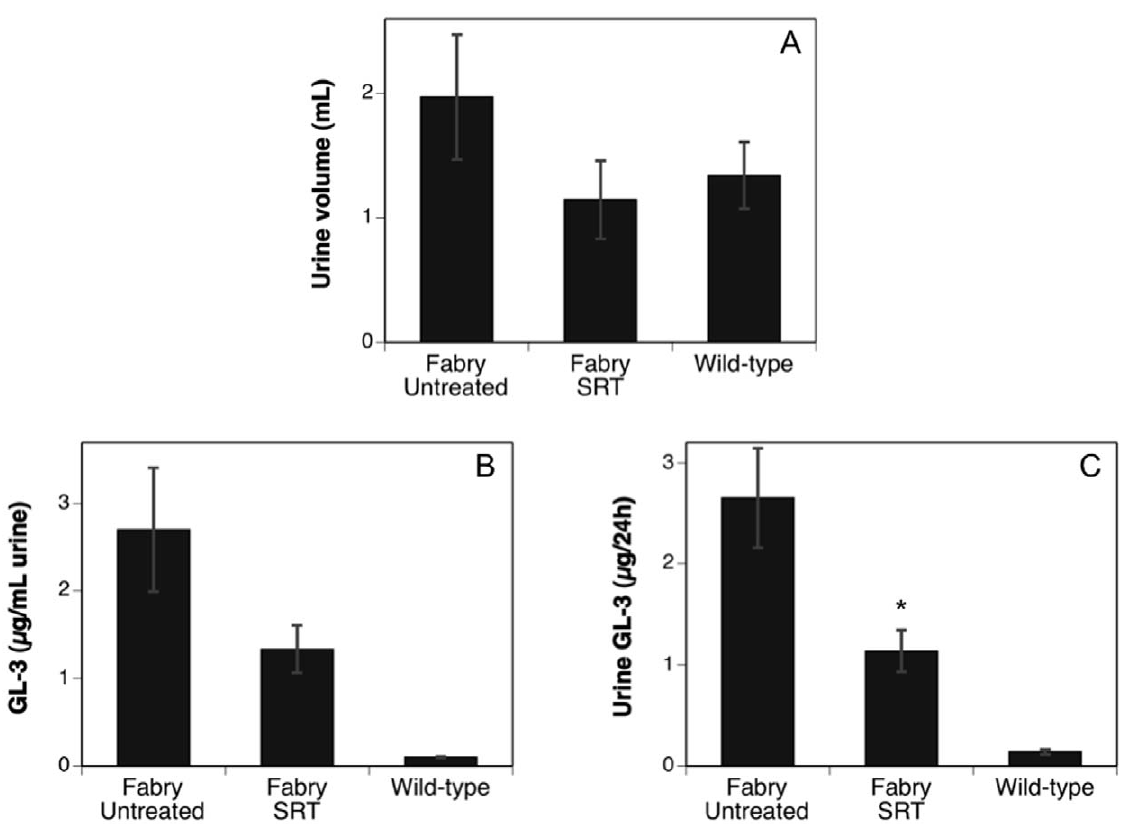
Figure 2. Substrate reduction therapy normalizes urine volume and decreases urine GL-3 levels. Treated Fabry mice received eliglustat tartrate as a component of their food beginning at 5 weeks of age. Urine was collected from eliglustat tartrate (SRT)-treated or untreated Fabry mice and also from age-matched wild-type mice (11-months of age) housed in metabolic cages for 24 h. ( A ) Total urine volume. ( B ) Concentration of GL-3 in the urine. ( C ) Total GL-3 excreted in urine over 24 h. Data are shown as mean 6 SEM (n=15 mice/group). Statistics were determined using the Graphpad Prism software t test (*=p , 0.05 compared to Fabry untreated).